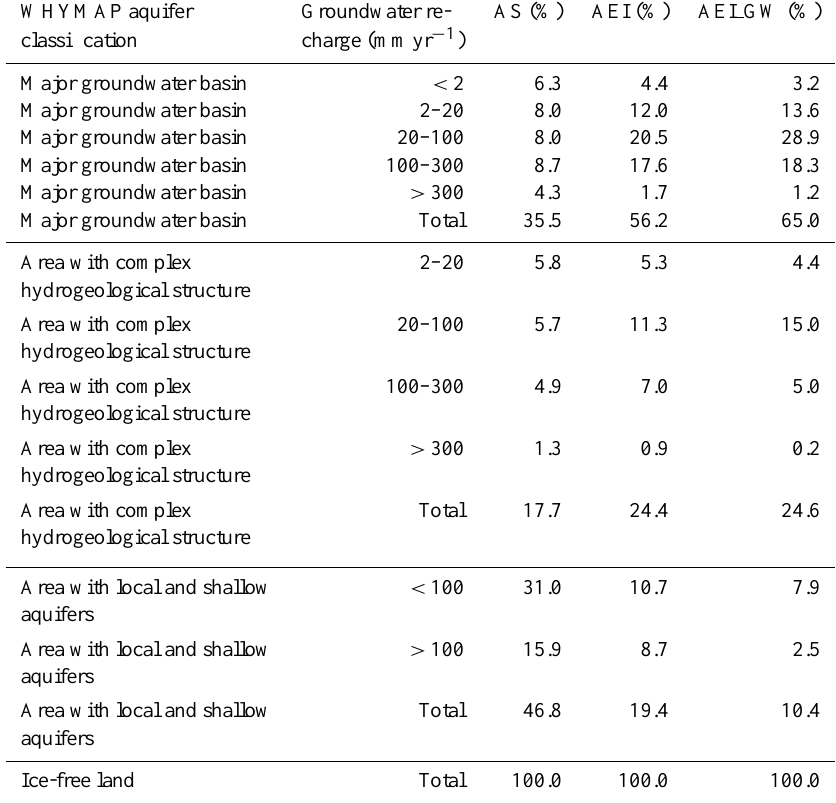
Table 4. Percentage of total surface area (AS), area equipped for irrigation (AEI) and area equipped for irrigation with groundwater (AEI GW) per WHYMAP aquifer class and groundwater recharge